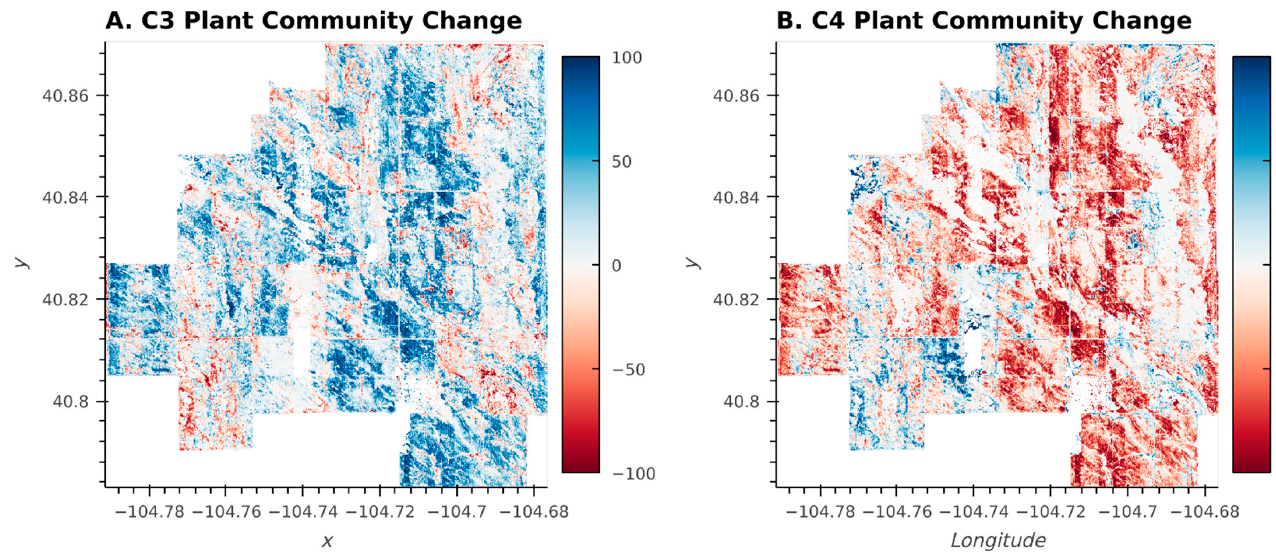
Figure 8. Percent change in plant community classes dominated by C3 ( A ) and C4 ( B ) species between 2013 and 2017. Blue indicates an increase between 2013 and 2017 while red indicates a decrease.